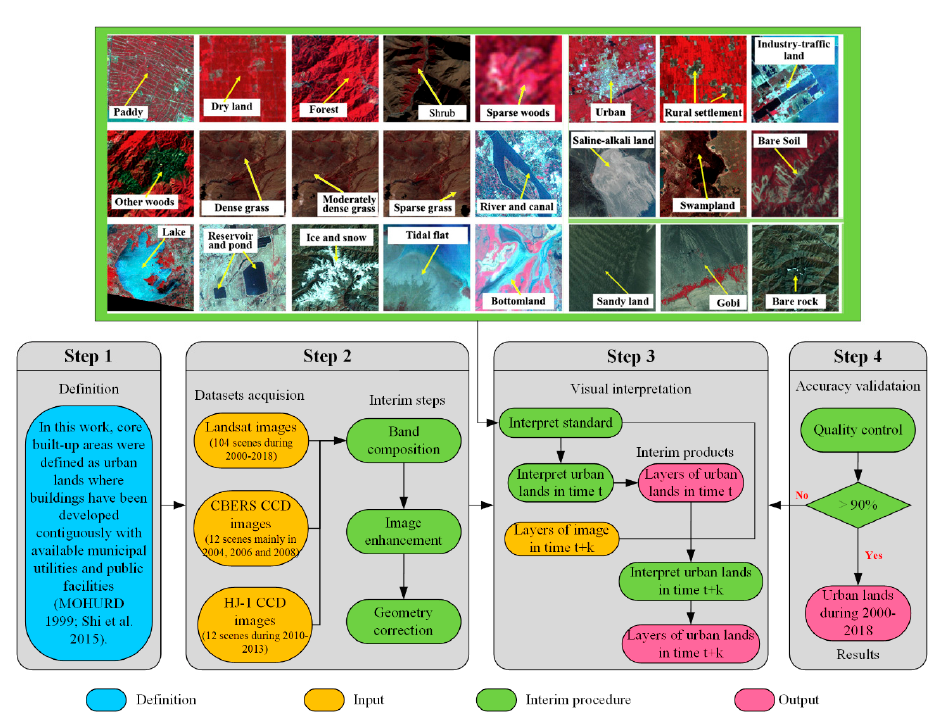
Figure 2. Flowchart for extracting urban lands during 2000–2018. The definition of urban lands was based on Shi et al. and MOUHURD [32,33]. based on Shi et al. and MOUHURD